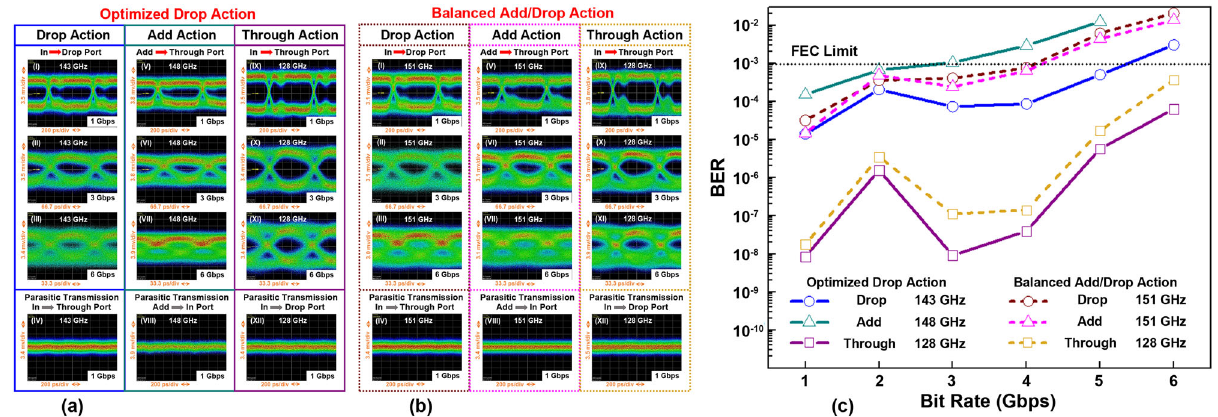
Fig. 6 Experimental study of the ADM circuits for THz communications. Eye patterns for the THz signals of different bit rates and different carrier frequencies propagating through a an ADM circuit with the optimized Drop action and b an ADM circuit with the balanced Add/Drop action. The measurements were performed at the following ports: (I – III) Drop port, (IV) Through port (Drop action: In port launch within grating stopband); (V – VII) Through port, (VIII) In port (Add action: Add port launch within grating stopband); (IX – XI) Through port, (XII) Drop port (Through action: In port launch within grating passband). The measurements are performed at various frequencies in the grating stopband (143, 148, 151 GHz) and the grating passband (128 GHz), which are also marked by black stars in Fig. 5. c Measured BER versus bit rate of the THz carrier wave propagating through two optimized ADM